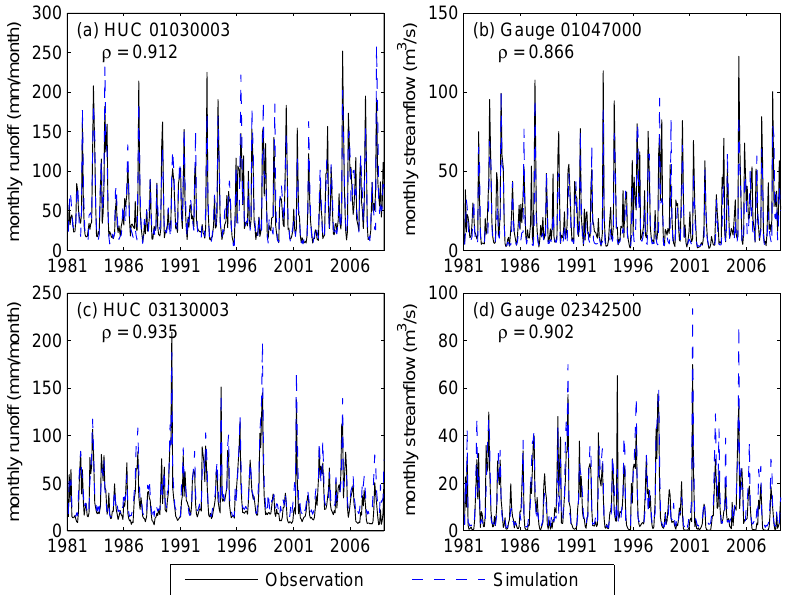
Fig. 8. The comparison between observed and simulated runoff (left panels) and observed and simulated streamflow (right panels). Gauge 01047000 is located at HUC01030003 and gauge 02342500 is located at HUC03130003.